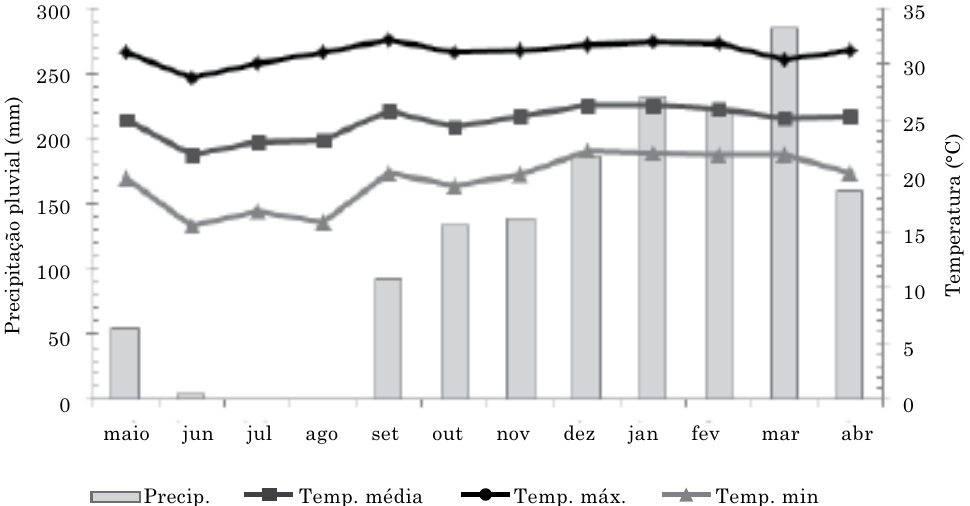
Figura 1. Valores médios da precipitação pluvial, temperaturas máxima, mínima e média do período de maio de 2010 a abril de 2011. Fonte: Laboratório de Hidráulica e Irrigação, Faculdade de Engenharia - UNESP, campus de Ilha